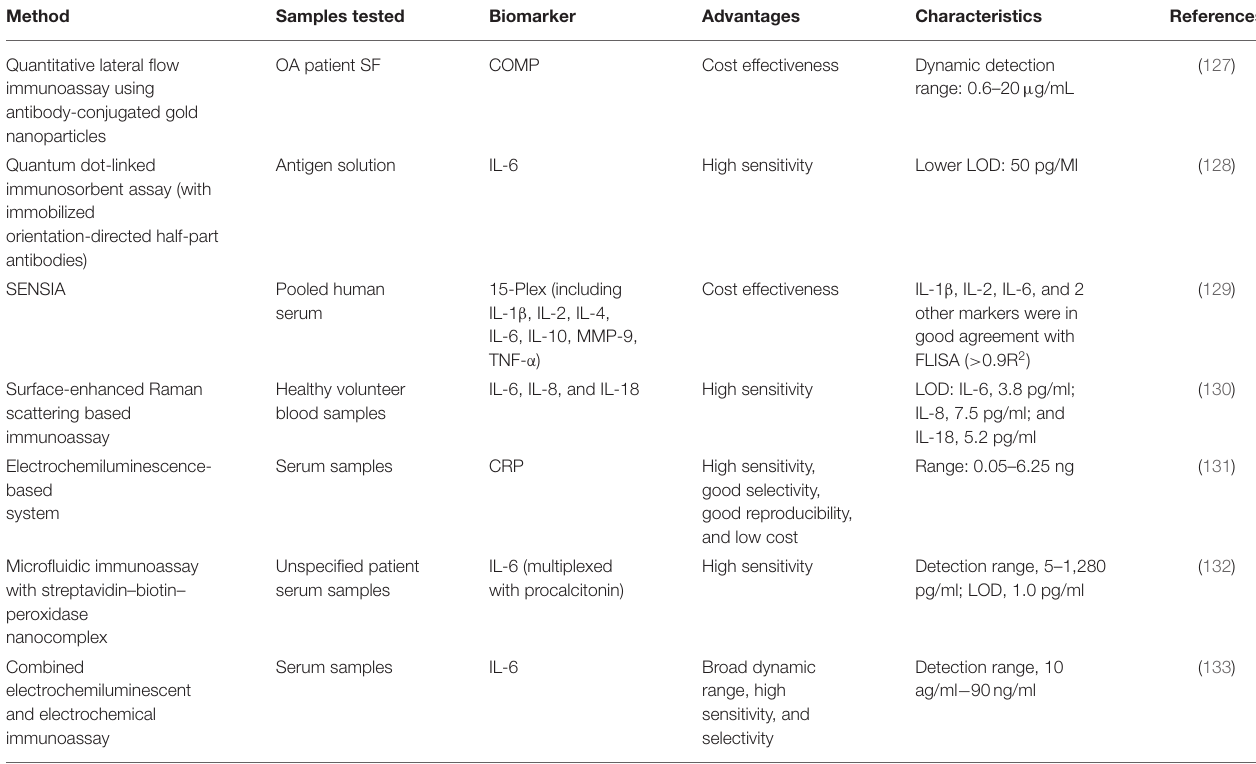
TABLE 2 | Enhanced immunoassays for detection of biochemical markers relevant to